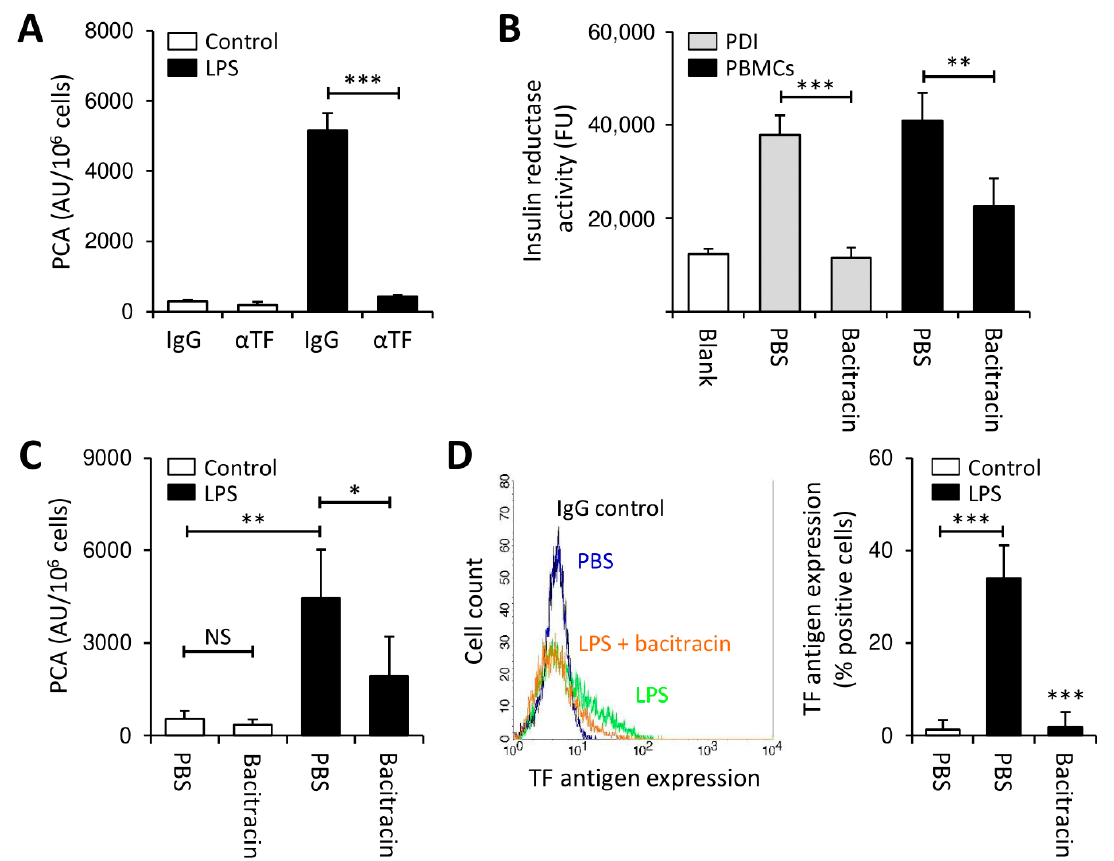
Figure 1. Thiol isomerases regulate lipopolysaccharide (LPS)-induced tissue factor (TF) expression in peripheral blood mononuclear cells (PBMCs). ( A ) PBMCs (2 × 10 6 /mL) were incubated with LPS (100 ng/mL) or PBS (control) for 4 h at 37 ◦ C and subsequently analyzed for procoagulant activity (PCA) by single-stage clotting assay (mean ± SD, n = 6). An inhibitory TF antibody ( α TF) was added in comparison to IgG isotype control to demonstrate TF specificity. ( B ) Cell-associated thiol isomerase activity was measured on freshly isolated PBMCs following incubation with PBS or bacitracin (5 mM) for 30 min using a fluorogenic insulin reductase activity assay (mean ± SD, n = 3). Recombinant human PDI, as provided by the manufacturer, served as positive control. ( C , D ) Incubation of PBMCs with LPS or PBS for 4 h at 37 ◦ C was carried out in the presence or absence of 5 mM bacitracin. Cells were then assessed for PCA by single-stage clotting assay (mean ± SD, n = 6) or monocyte TF antigen expression by flow cytometry (mean ± SD, n = 5). p -values are according to Tukey’s post-hoc test (NS, not significant; *, p < 0.05; **, p < 0.01; ***, p <